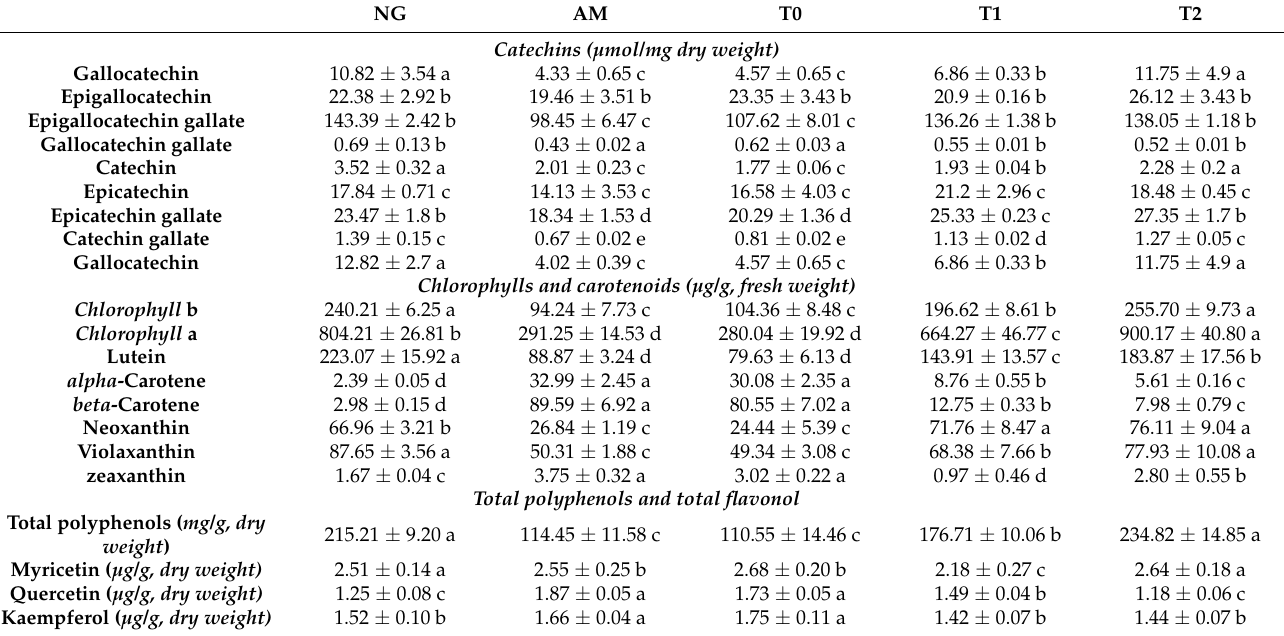
Table 1. Contents of main catechins, chlorophylls and carotenoids in albino and green leaves of ‘Baiye 1 (cid:48) tea at the indicated time points under greening process obtained by HPLC-DAD (except total polyphenols). Different letters (a, b, c, d, e) indicate significantly different values between time points at p < 0.01 level ( n = 6). NG: normal green leaf, AM: albino mutant leaf, T0: 0 day after starting greening, T1: 3 days after starting greening, T2: 6 days after starting